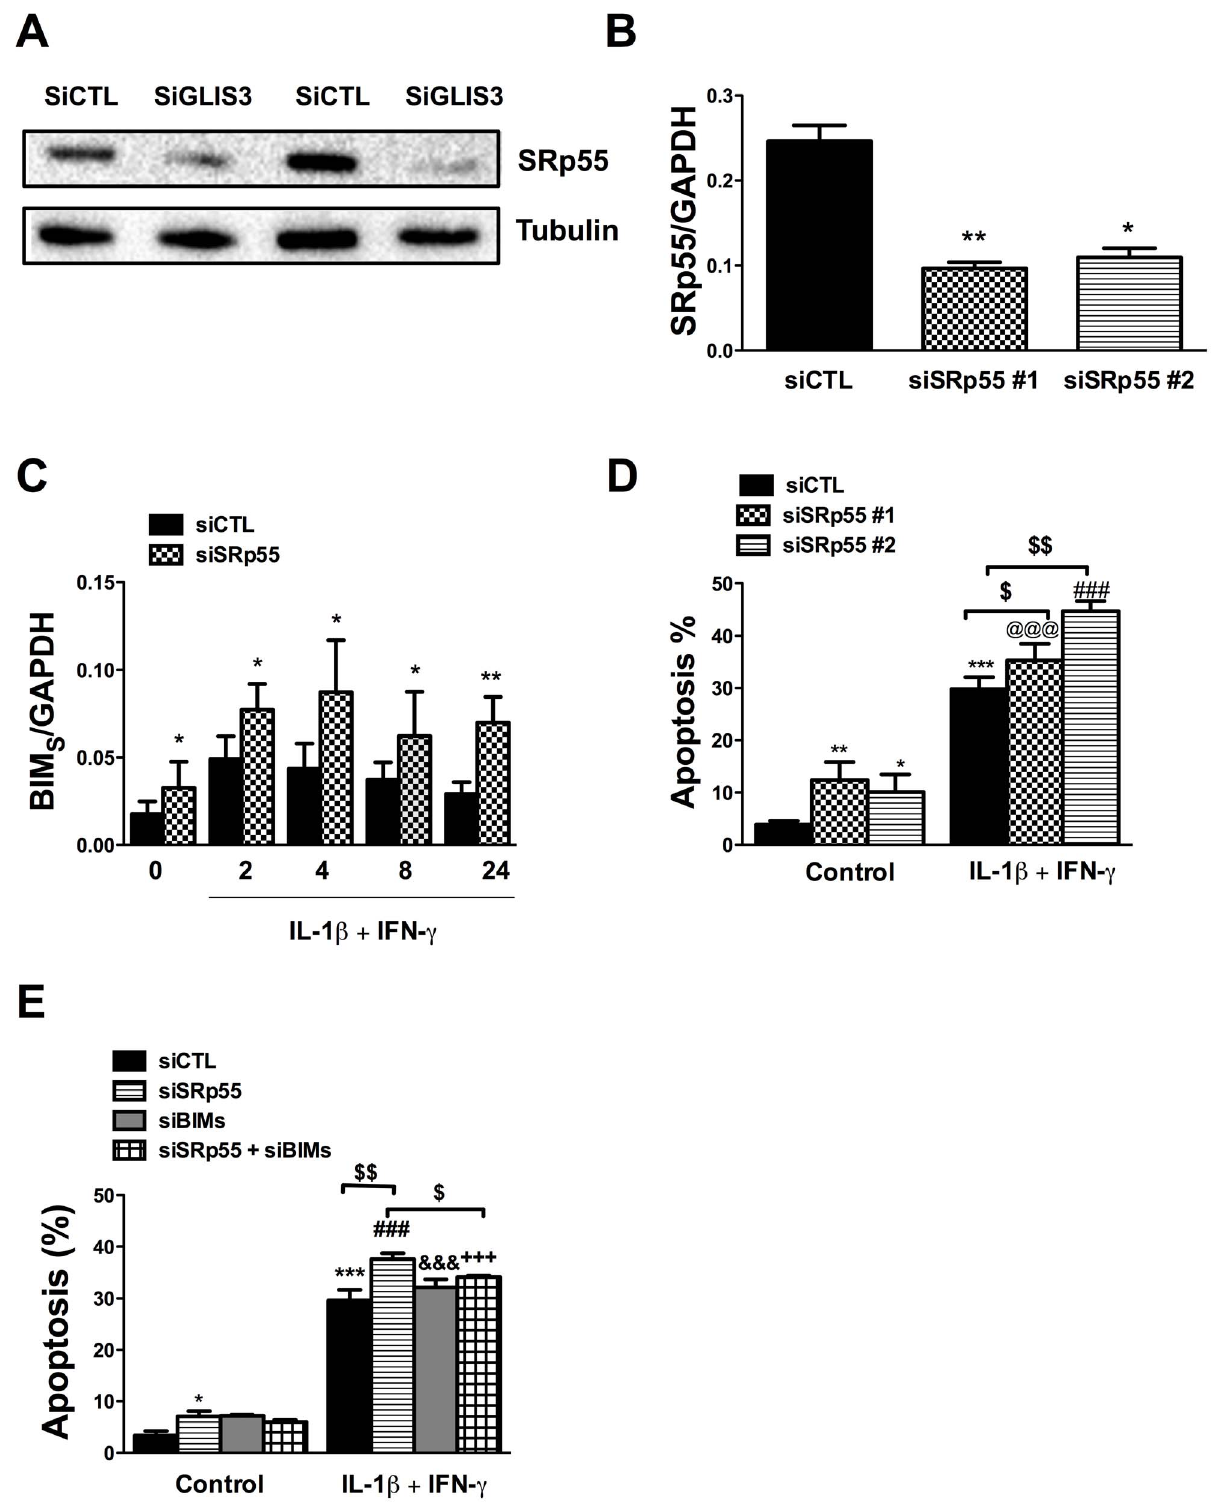
Figure 7. GLIS3 KD decreases SRp55 expression in INS-1E cells. INS-1E cells were transfected with control, GLIS3 (A), SRp55 (B, C, D and E) and Bim S siRNAs (E). After 48 h cells were incubated with cytokines (C–E) for measuring apoptosis and collected at different time points for real-time PCR analyses. (A) Representative blot of 2 independent experiments for SRp55 protein expression after GLIS3 KD (n=7; densitometry is provided in Results); (B) SRp55 mRNA expression after KD with two different siRNAs (SRp55 # 1 and SRp55 # 2); (C) mRNA expression of Bim S after SRp55 KD and exposure to cytokines; (D, E) apoptosis in cells transfected with SRp55 and/or a Bim siRNA targeting preferentially Bim S (siBim S ). Apoptosis was measured using nuclear dyes. Results are means 6 SEM (n=4–7). * P , 0.05, ** P , 0.01, *** P , 0.001 vs . siCTL without cytokines @@@ P , 0.001 vs . siSRp55 # 1; ### P , 0.001 vs . siSRp55 # 2; &&& P , 0.001 vs . siBim S ; +++ P , 0.001 vs . siSRp55 + siBim S ; $ P , 0.05 or $$ P , 0.01 as indicated by the bars. Paired t- test (7B and 7C) or ANOVA followed by paired t -test with Bonferroni’s correction (7D and 7E). doi:10.1371/journal.pgen.1003532.g007 PLOS Genetics |